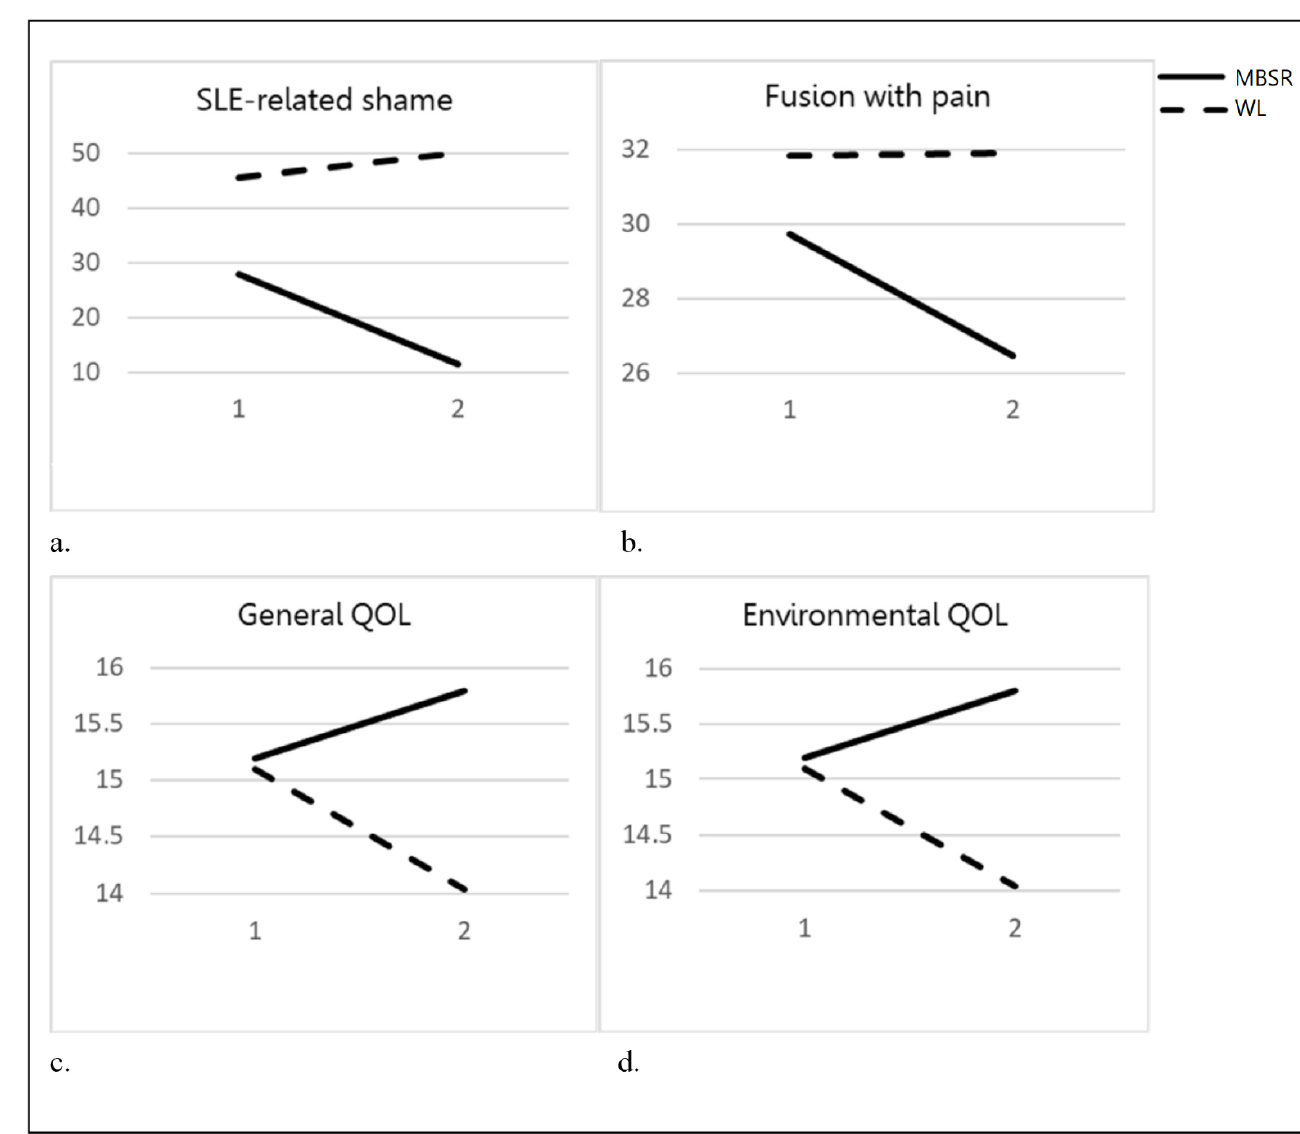
Figure 2. Pre- Intervention to Post-Intervention Differences between the MBSR and WL. Note: Pre-intervention (1); post- intervention (2). ( a ) Changes in cognitive Fusion among MBSR group and WL; ( b ) Changes in SLE-related Shame among MBSR group and WL; ( c ) Changes in General Quality of Life among MBSR group and WL; ( d ) Changes in Environmental Quality of Life among MBSR group and WL.